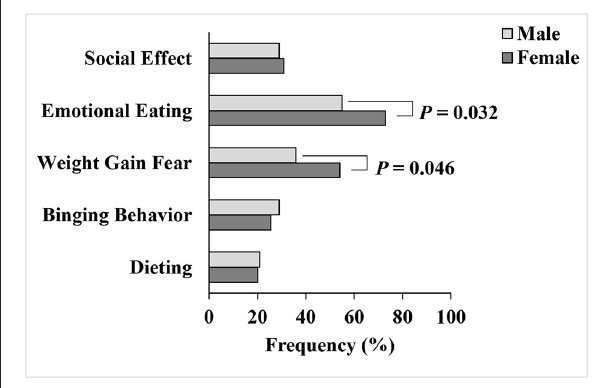
FIGURE 3 | Dieting and eating behaviors of male and female college students.